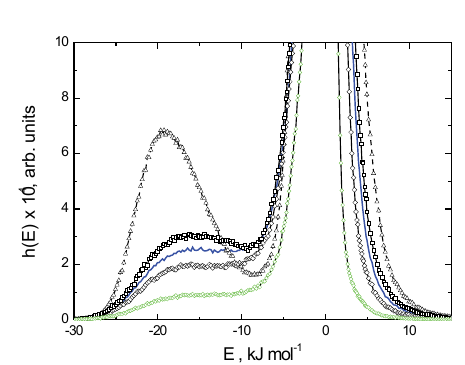
Figure 1. Normalized statistical distributions of pair interaction en- ergy E in water calculated for the thermodynamic states listed in Table 1: TS1 (─∆─) , TS2 (─□─) , TS3 ( ──) , TS4 (─ ◊ ─) , TS5 (─○─)